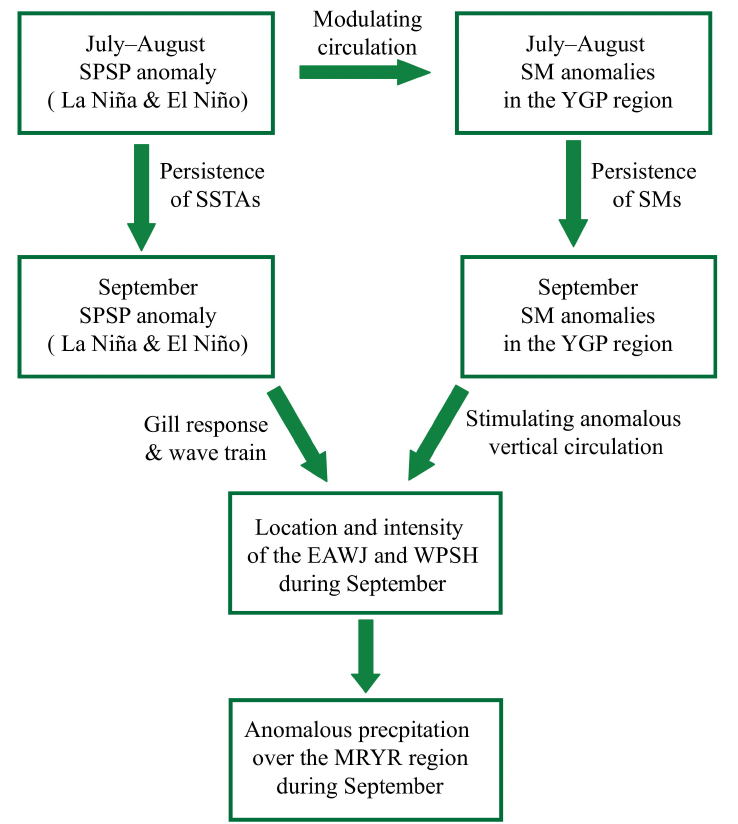
Figure 11. Schematic diagram summarizing the processes linking the precursory SPSP and YGP SM signals and September precipitation over the MRYR